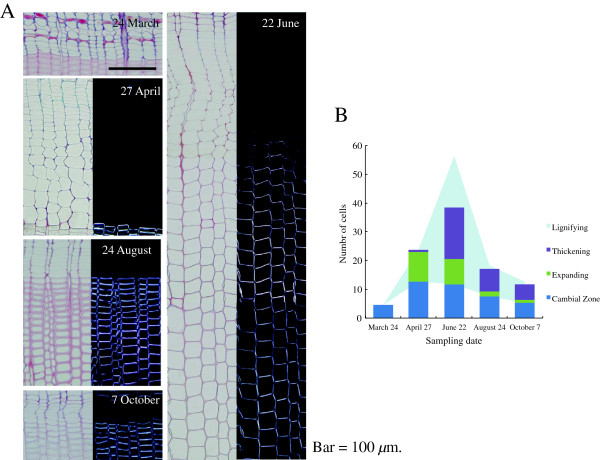
Cross-sections of cambial zone and differentiating xylem of Cryptomeria japonica trees. A. Cross-sections viewed under an ordinary light microscope (24 March) and pairs of ordinary (left) and polarizing (right) light microscope images for the same field (27 April, 22 June, 24 August and 7 October). B. Number of cells in cambial zone and differentiating xylem. Cells in differentiating xylem were categorized into expanding cells, thickening cells and lignifying cells in accordance with ordinary and polarizing light microscope observations.